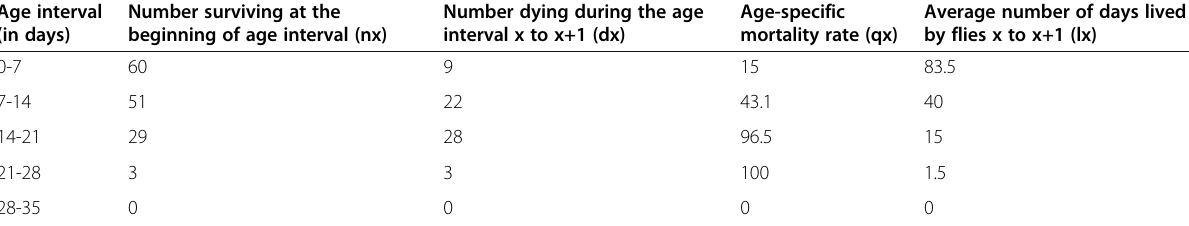
Table 3 Life table depicting survival of D. melanogaster in media with 0.8 mg/L NaF Age interval Number surviving at the (in days) beginning of age interval (nx)